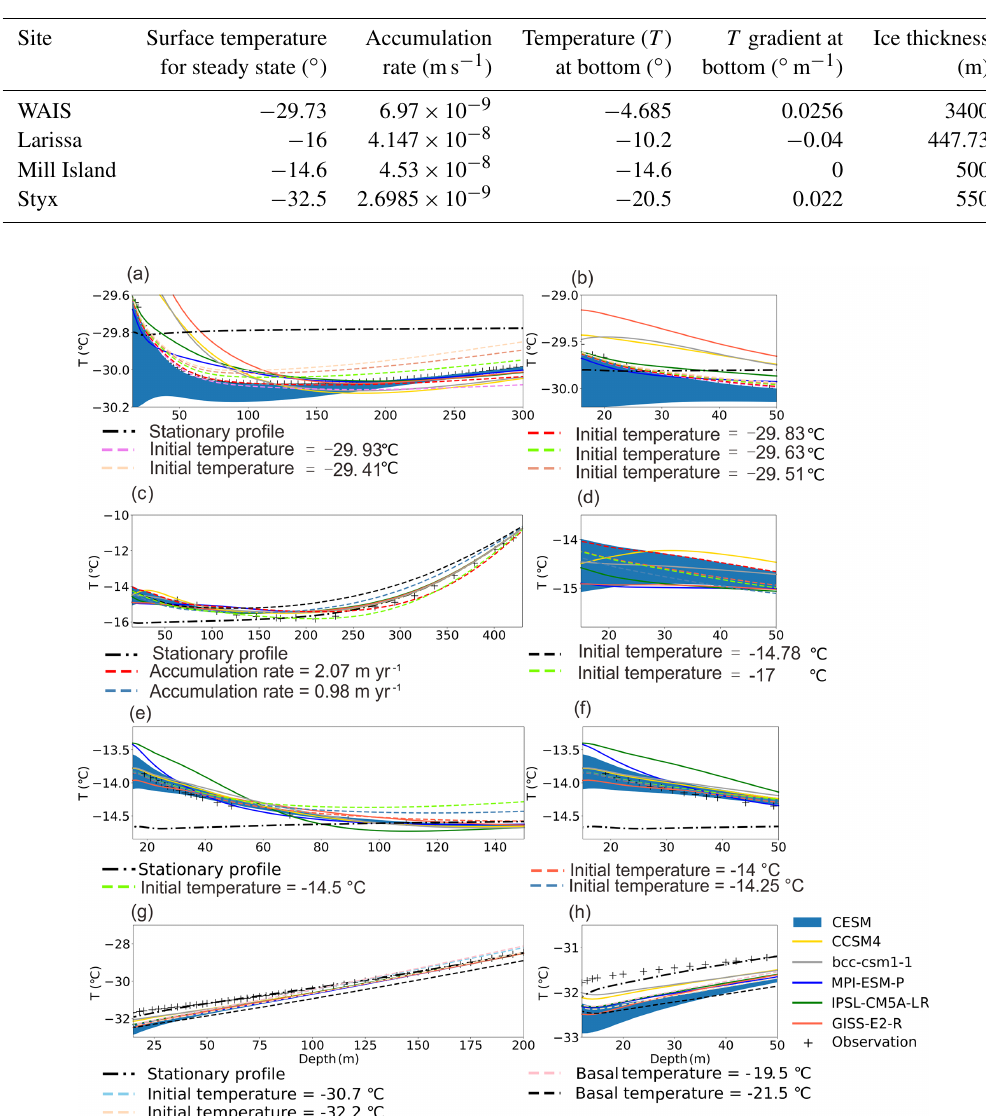
Table 3. Optimal parameters used to simulate subsurface temperature profile in the forward model driven by the reconstruction for each site: